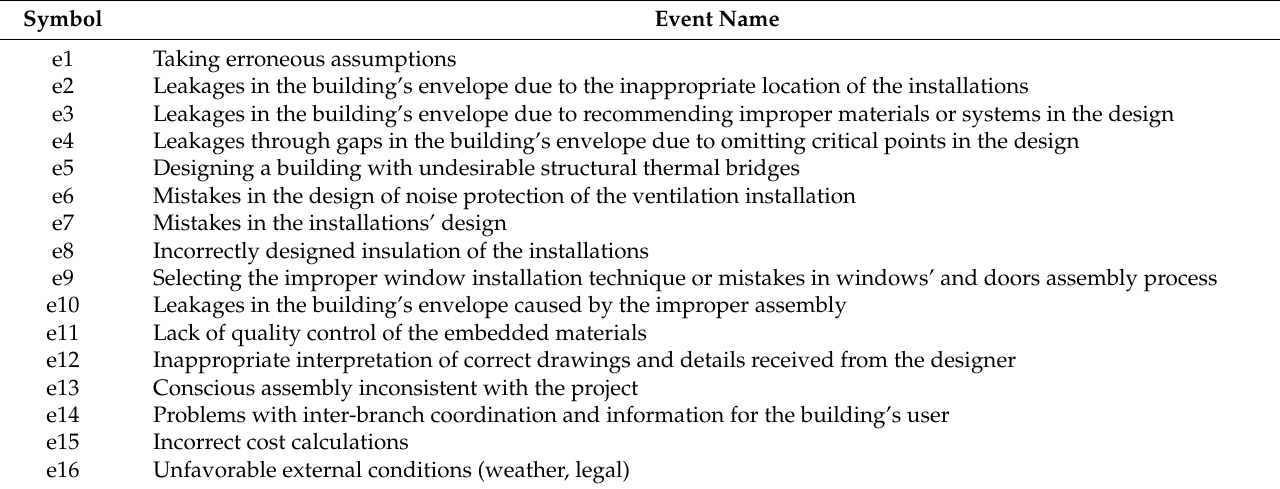
Table 1. Identified basic and underdeveloped events.